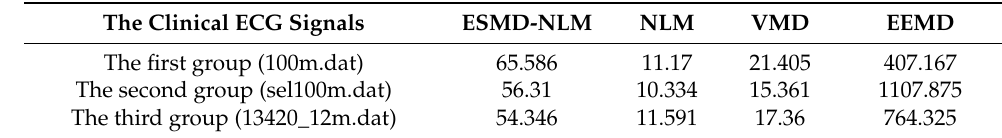
Table 5. The implementation time (s) for the ESMD-NLM, NLM, VMD and EEMD methods operating on the three groups of clinical ECG